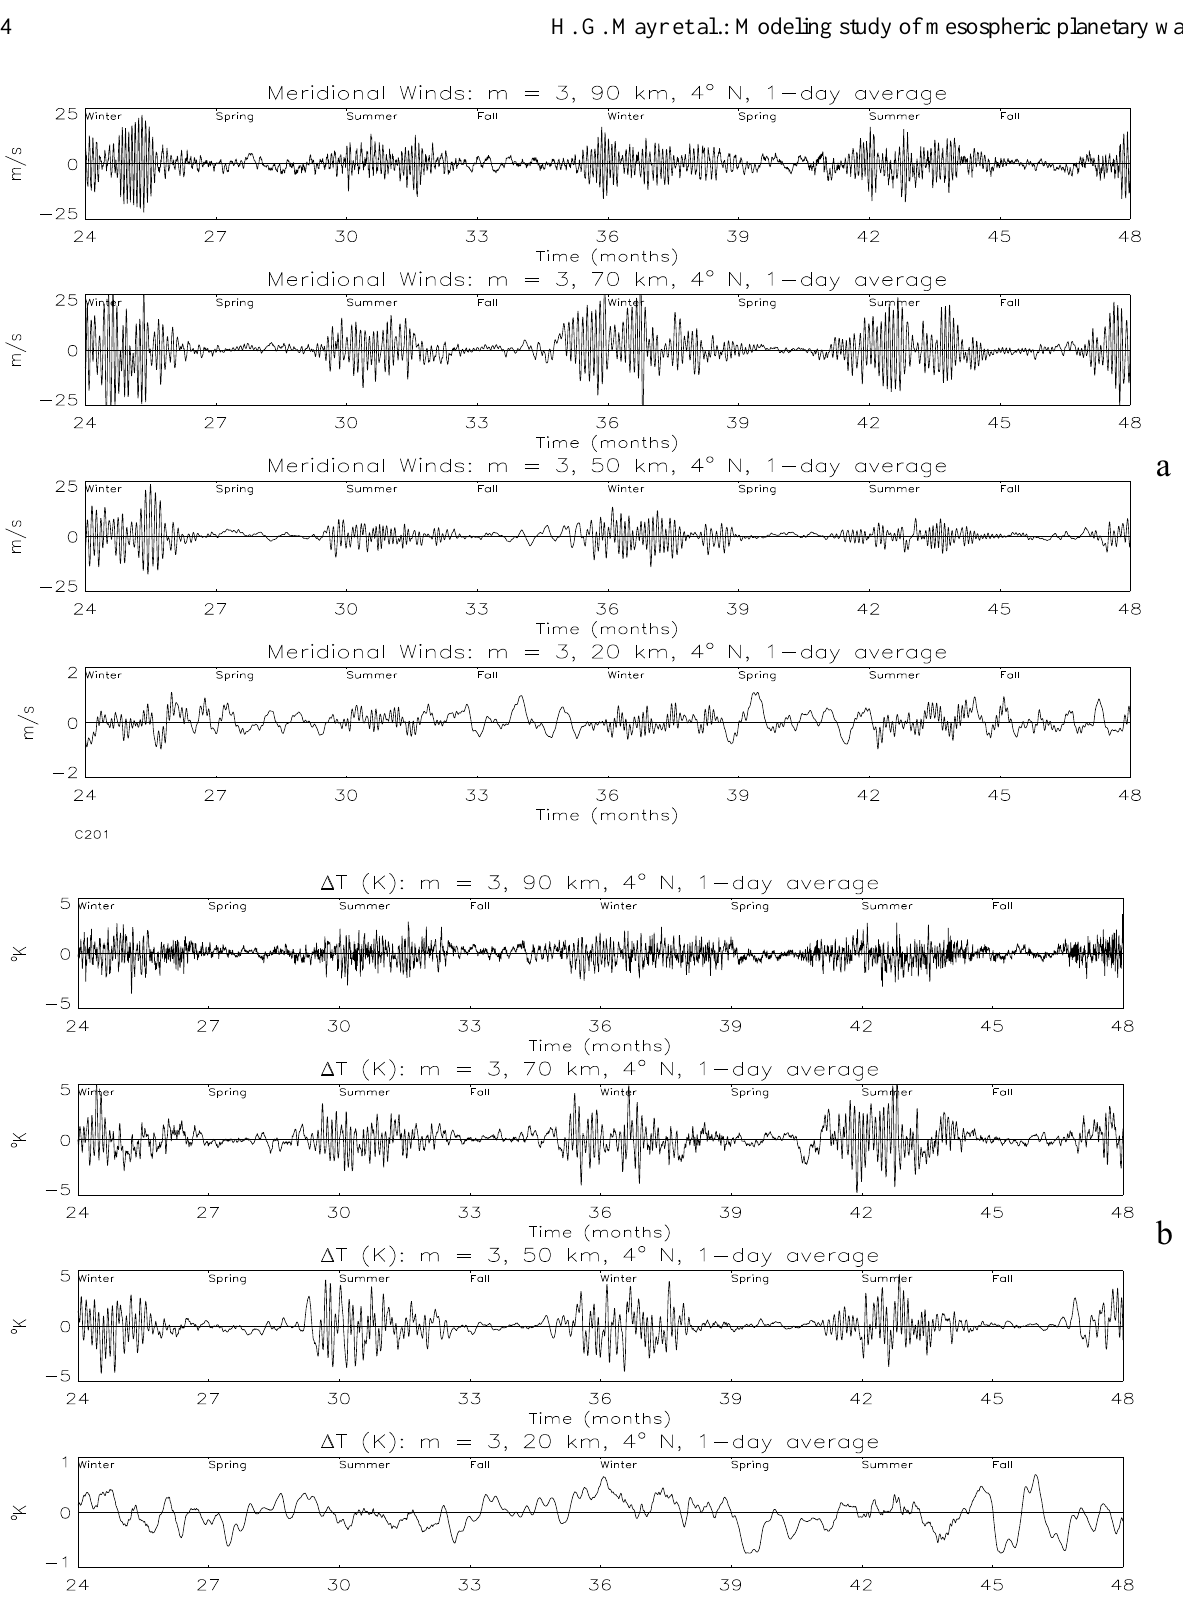
Fig. 7. Meridional winds ( a ) and temperature perturbations ( b ) of PWs for m=3 at 4 ◦ latitude and at different altitudes from 20 to 90km. The short period waves dominate during summer and winter months, except at 20km, where the long period waves are